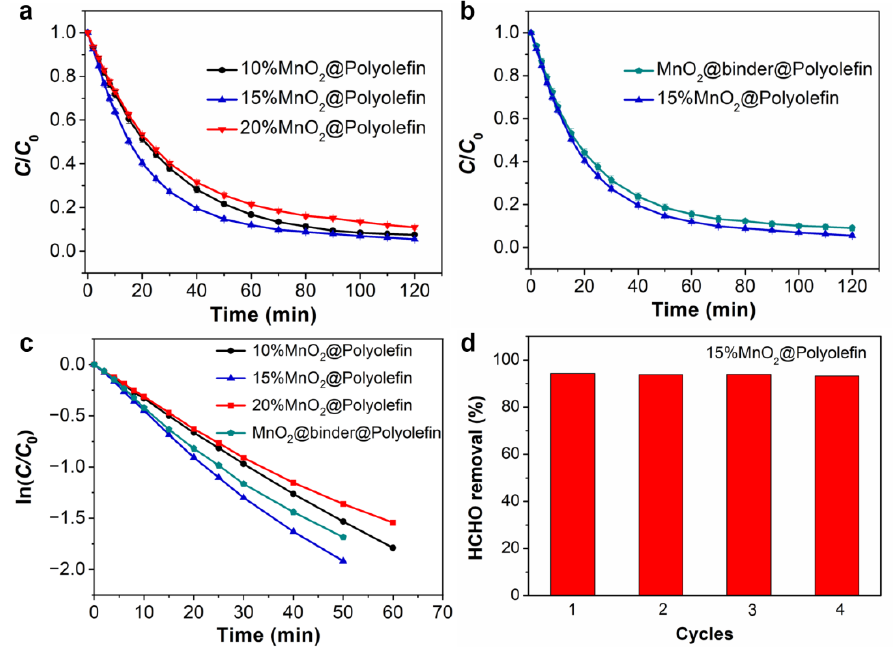
Figure 5. ( a ) HCHO removal test on 10%MnO 2 @Polyolefin, 15%MnO 2 @Polyolefin,